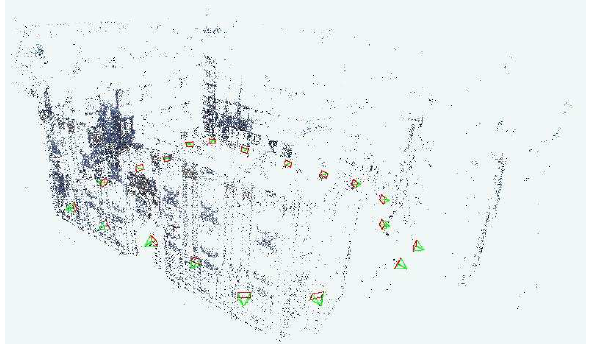
Figure 10 : EPFL-castle orientation.